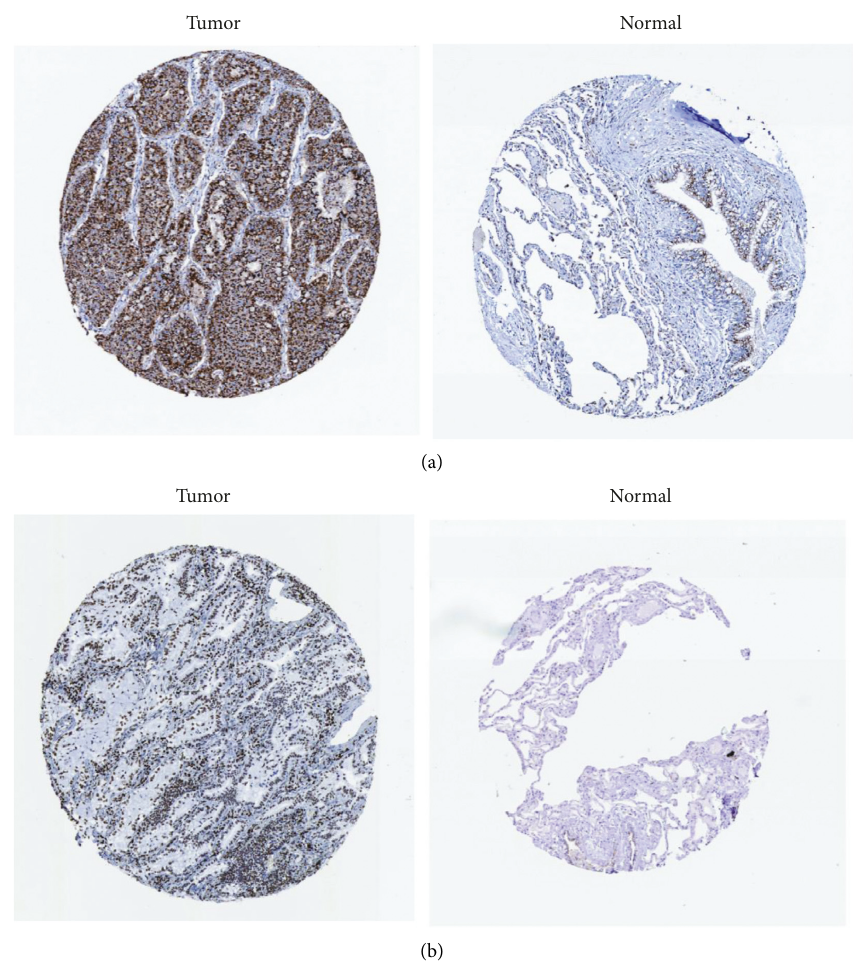
Figure 10: (a) Immunohistochemical staining results of TM9SF3 in LUAD from HPA database. (b) Immunohistochemical staining results of RAB1A in LUAD from HPA